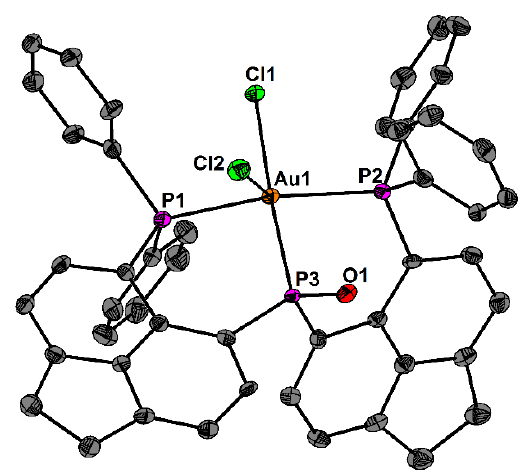
Figure 1. Molecular structure of (6-Ph 2 P-Ace-5-) 2 P(O)AuCl 2 ( 1 ) showing 50% probability ellipsoids and the essential atomic numbering. Selected bond parameters [Å ,°]: Au1–P1 2.345(2), Au1–P2